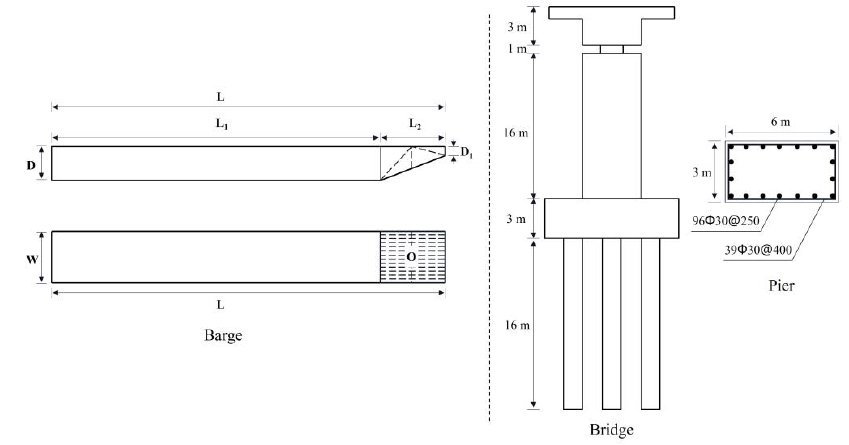
Figure 3. Geometrical dimensions of barge and whole bridge models. Table 4. The size of JH barge.